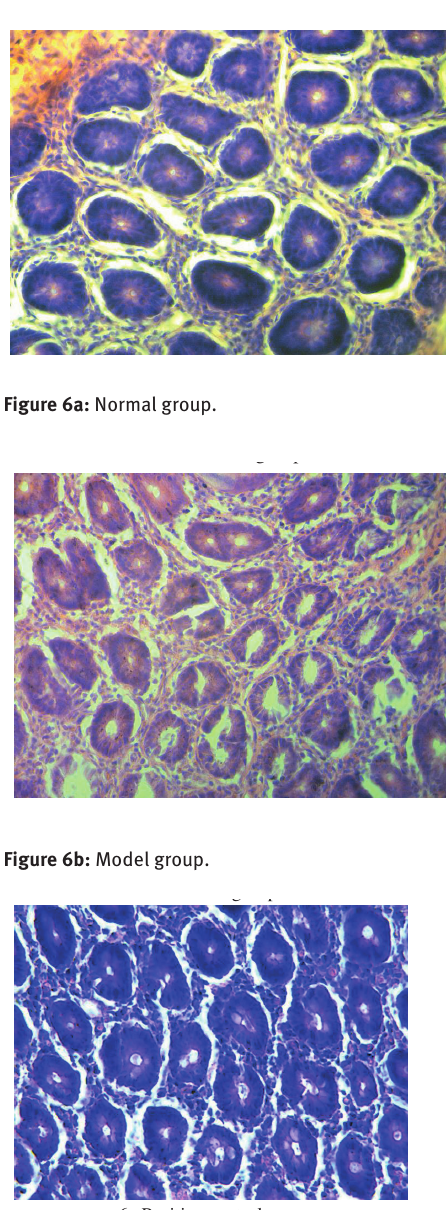
Figure 6c: Positive control